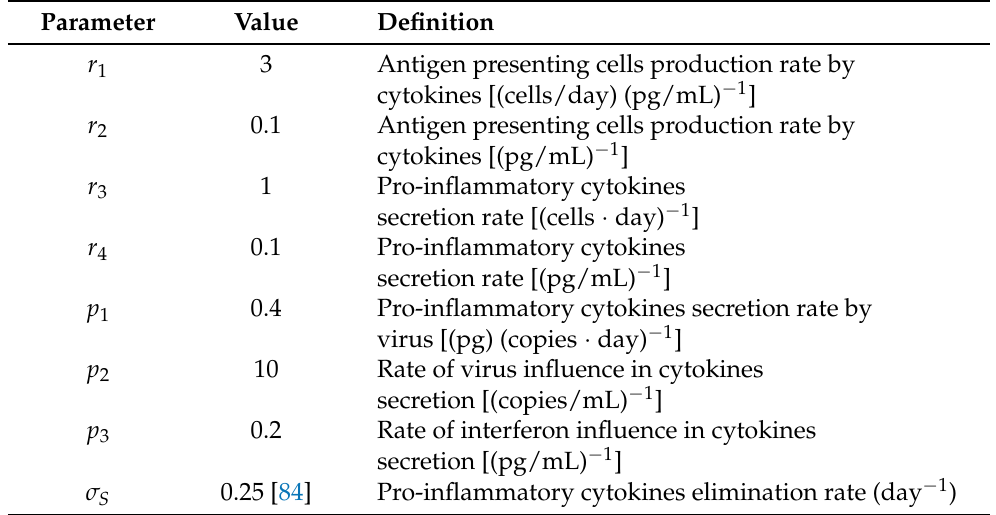
Table A3. Parameters for cytokine storm.